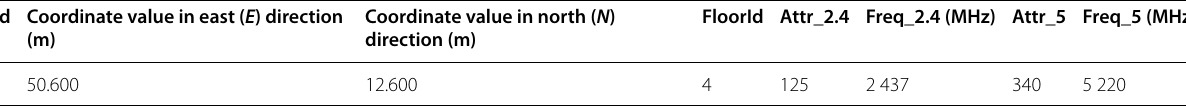
Table 10 An example of information of pre-installed APs Id Coordinate value in east ( E ) direction (m)